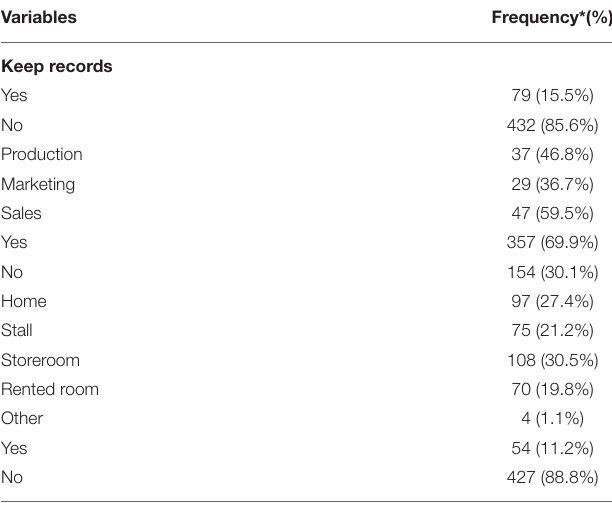
TABLE 7 | Street food vendor’s record-keeping practices.